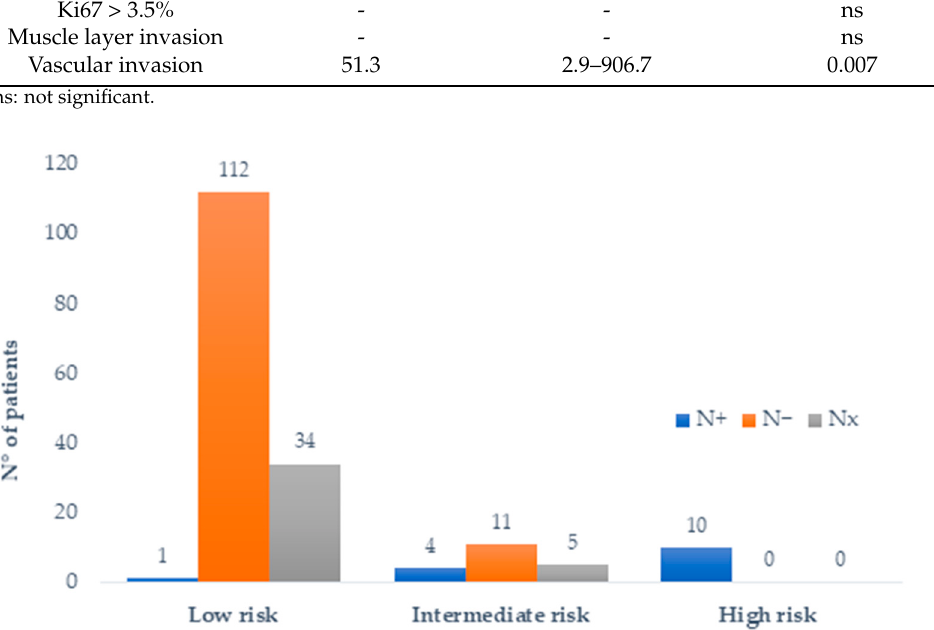
Figure 3. Distribution of patients and nodal status according to NOVARA score. Nx: unknown nodal status; N − : absence of lymph node metastases; N+: presence of lymph node metastases. status; N − : absence of lymph node metastases; N+: presence of lymph node